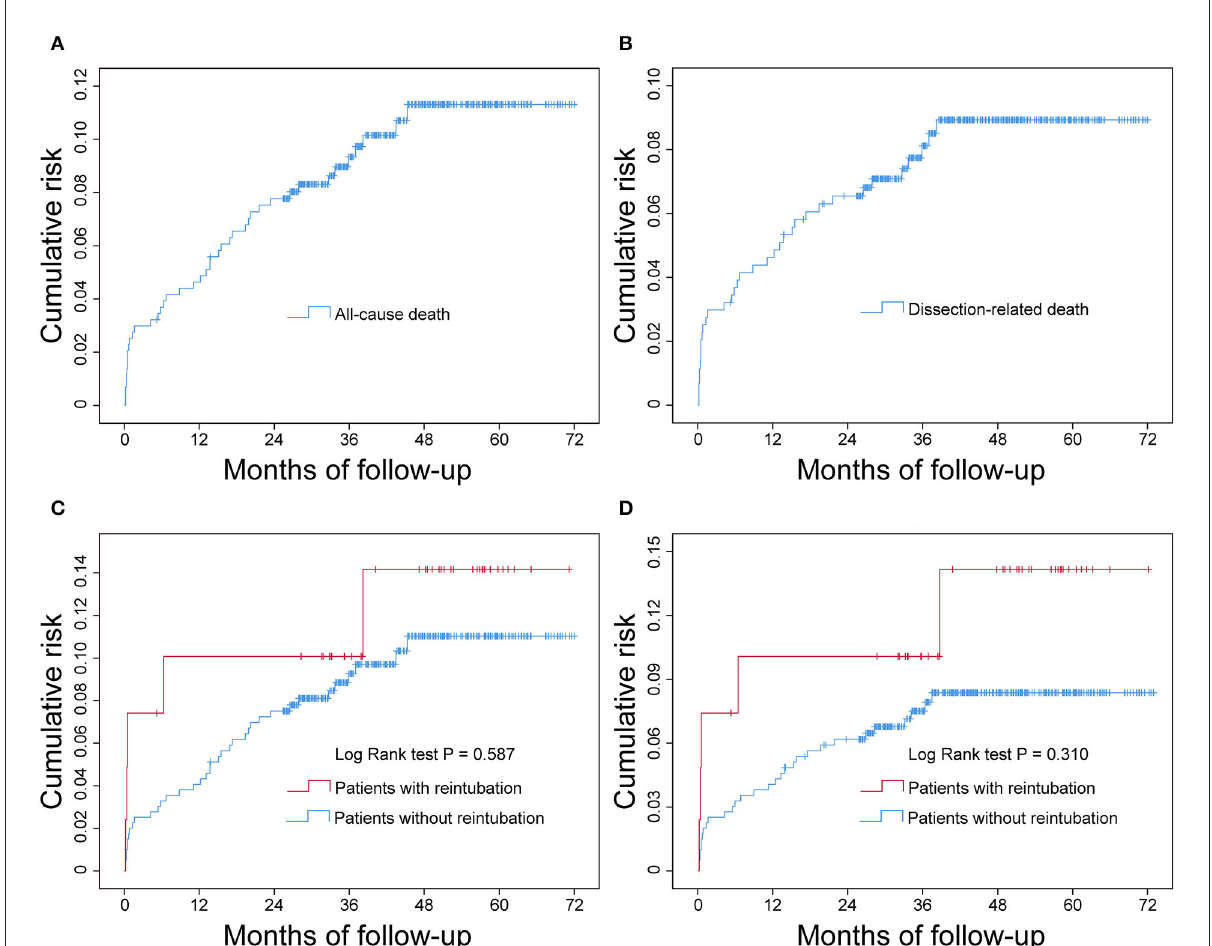
FIGURE3 Cumulative all-cause mortality and dissection-related mortality after successful discharge in patients undergoing AADS and the comparison between patients with and without reintubation. The statistical results showed that the difference was not significant between the two groups. (A) Cumulative all-cause mortality, (B) cumulative dissection-related mortality, (C) comparison of cumulative all-cause mortality between patients with and without reintubation, and (D) comparison of cumulative dissection-related mortality between patients with and without reintubation. AADS, Stanford type A acute aortic dissection